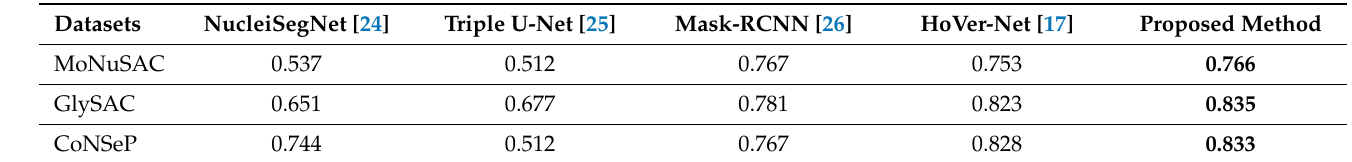
Table 2. Cell segmentation results on three datasets (MoNuSAC, GlySAC and CoNSeP) using Dice score.